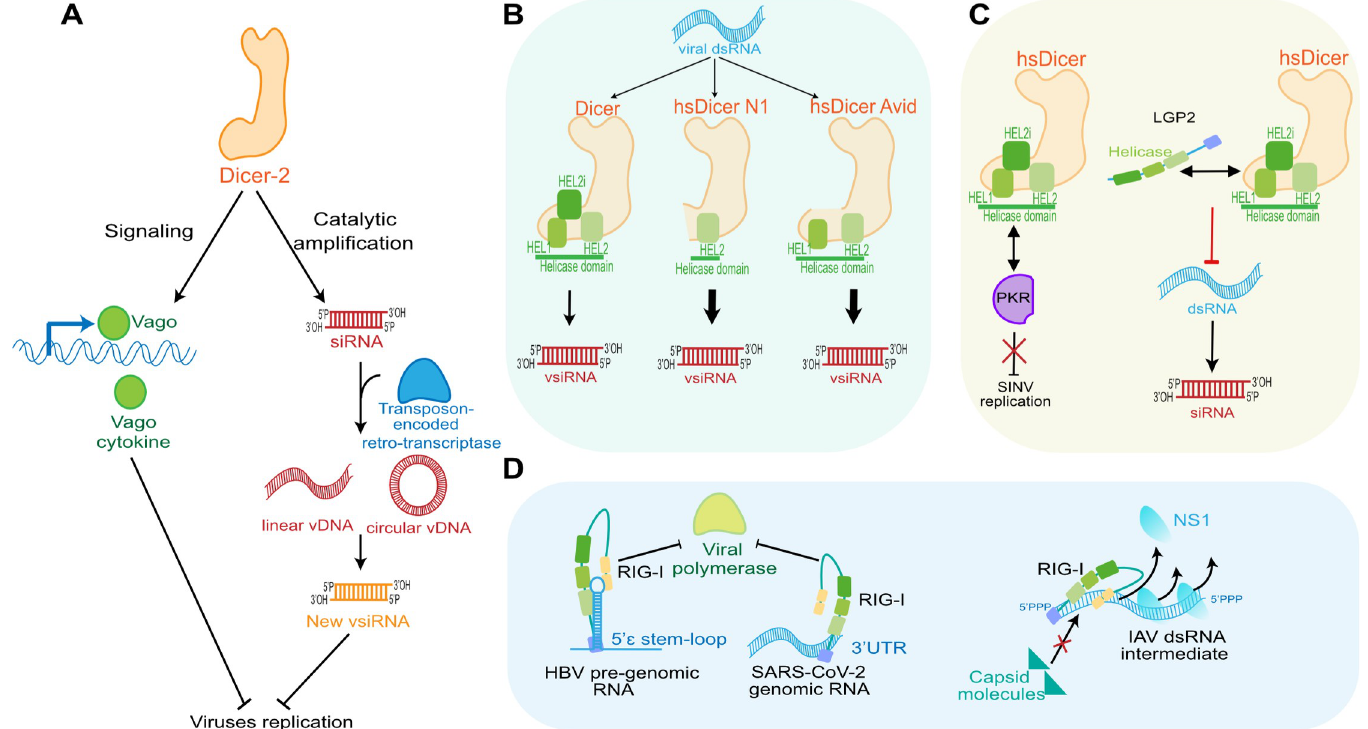
Fig 5. Noncanonical functions of helicases during viral infection. (A) In insects, Dicer-2 is involved in 2 antiviral pathways in addition to its canonical role in RNAi. First, its helicase domain is necessary to induce the transcription of Vago, a Drosophila cytokine. Vago inhibits viral replication through a yet to be defined mechanism. Second, in Drosophila and mosquitoes, Dicer-2-generated siRNAs can be used by a transposon-encoded retrotranscriptase to generate both linear and circular vDNA molecules. These vDNA can be a source of new vsiRNA duplexes, thereby amplifying the antiviral signal in the cell. (B) In the case of mammalian Dicer, its involvement in direct catalytic antiviral pathways remains debated. During viral infection of undifferentiated ESCs, Dicer is responsible for the production of vsiRNAs functionally involved in the blocking of viral replication. Artificial generation of a helicase-truncated form of Dicer (N1) allows to uncover antiviral RNAi functions in differentiated cells as well. The recent discovery in human ES cells of a naturally occurring isoform of Dicer called Avid, which lacks the HEL2i domain, provides some support to the existence of antiviral RNAi in humans. (C) In human cells, Dicer is also at the center of many interactions, which could modulate either its own or the interacting protein functions. For instance, human Dicer interacts with PKR via its helicase domain and modulates its function during SINV infection. LGP2 is also interacting with the Dicer helicase domain and inhibits Dicer catalytic activity. (D) In mammalian cells, RLRs can be involved in steric obstruction of viral dsRNA. Thus, RIG-I can block the binding and catalytic action of viral proteins (polymerase or capsid) or displace them (NS1), thereby allowing recognition of the dsRNA by other antiviral proteins. dsRNA, double-stranded RNA; ESC, embryonic stem cell; HBV, hepatitis B virus; IAV, influenza A virus; PKR, protein kinase R; RLR, RIG-I-like receptor; RNAi, RNA interference; SARS-CoV-2, Severe Acute Respiratory Syndrome Coronavirus 2; SINV, Sindbis virus; siRNA, small interfering RNA; vDNA, viral